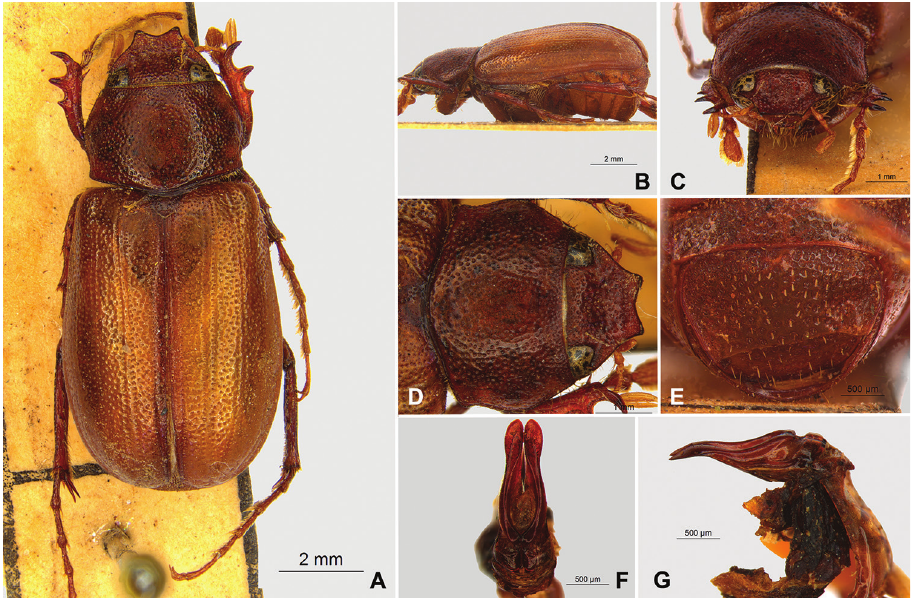
Figure 84. Liogenys pseudosanctaecrucis Cherman, sp. n. A Dorsal view B Lateral view C Frontal view D Clypeus and pronotum E Pygidium F Parameres, dorsal view G Parameres, lateral